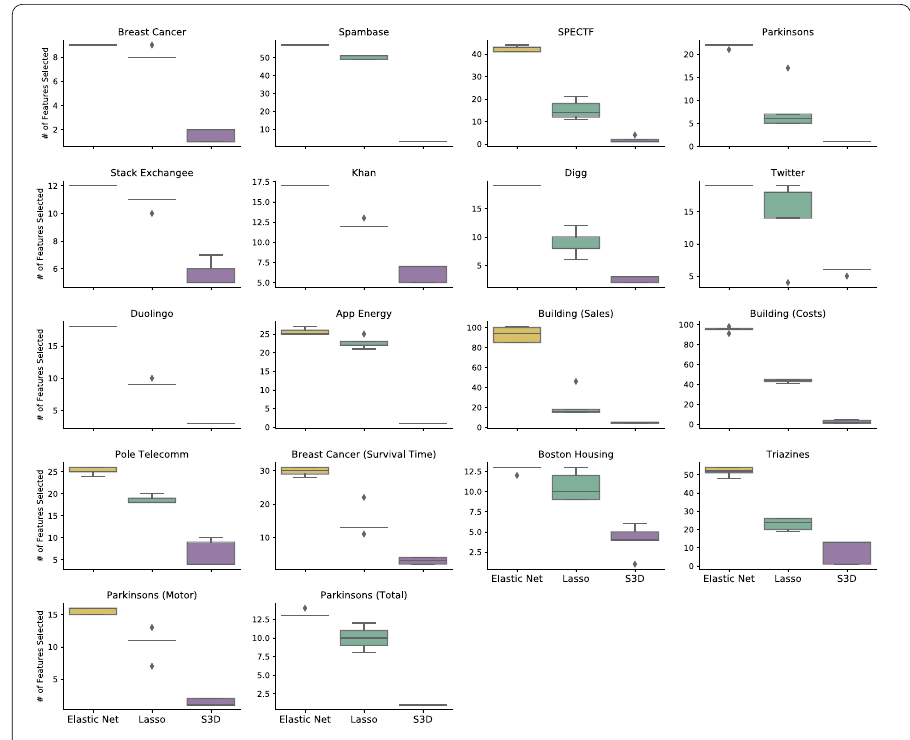
Figure 5 Number of features selected by elastic net and lasso regression, as well as S3D, across outer CV for all datasets. The five points in each box correspond to the number of features selected in each outer